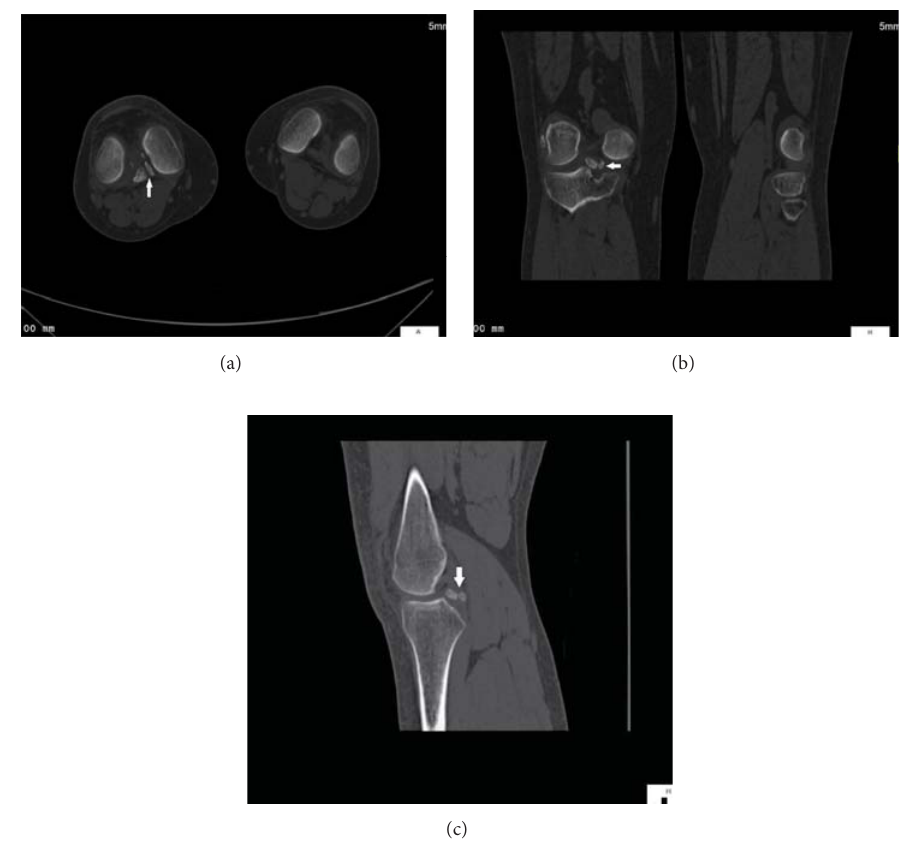
Figure 2: A 21-year young male student presented with chronic pain in the right knee joint for 1-2 years subsequently diagnosed as double meniscal ossicle of the knee. (a) Plain CT axial bone window images show well defined lamellated bone density lesions, two in number (solid arrow) in intra-articular region on medial aspect of right knee. (b) Plain CT coronal bone window images show well defined lamellated bone density lesions, two in number (solid arrow) in intra-articular region on medial aspect of right knee. (c) Plain CT sagittal bone window images show well defined lamellated bone density lesions, two in number (solid arrow) in intra-articular region on medial aspect of right